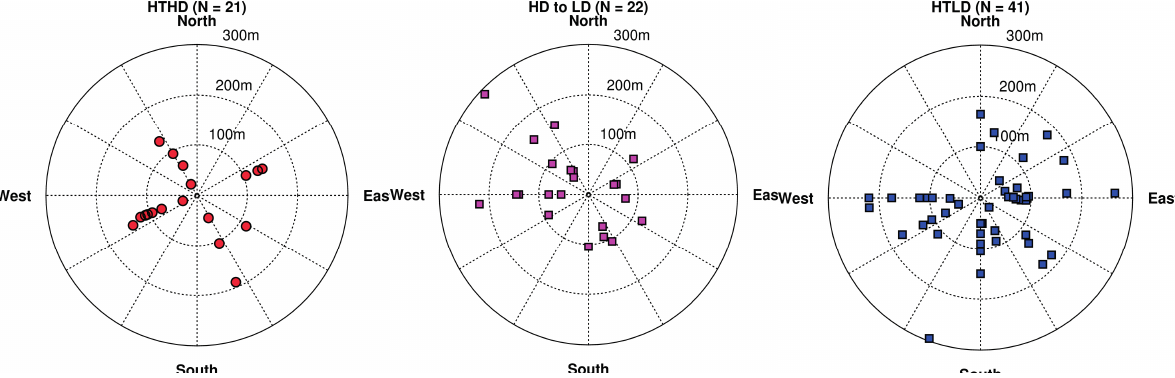
concentration for 2.5